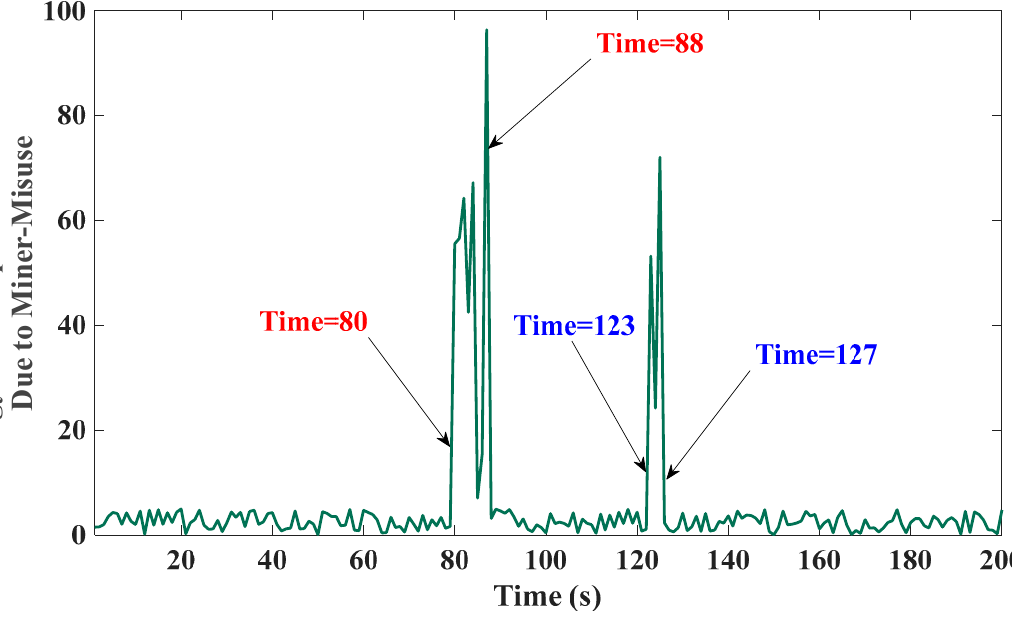
Figure 7. Illustration of the energy consumption deviations under miner misuses.